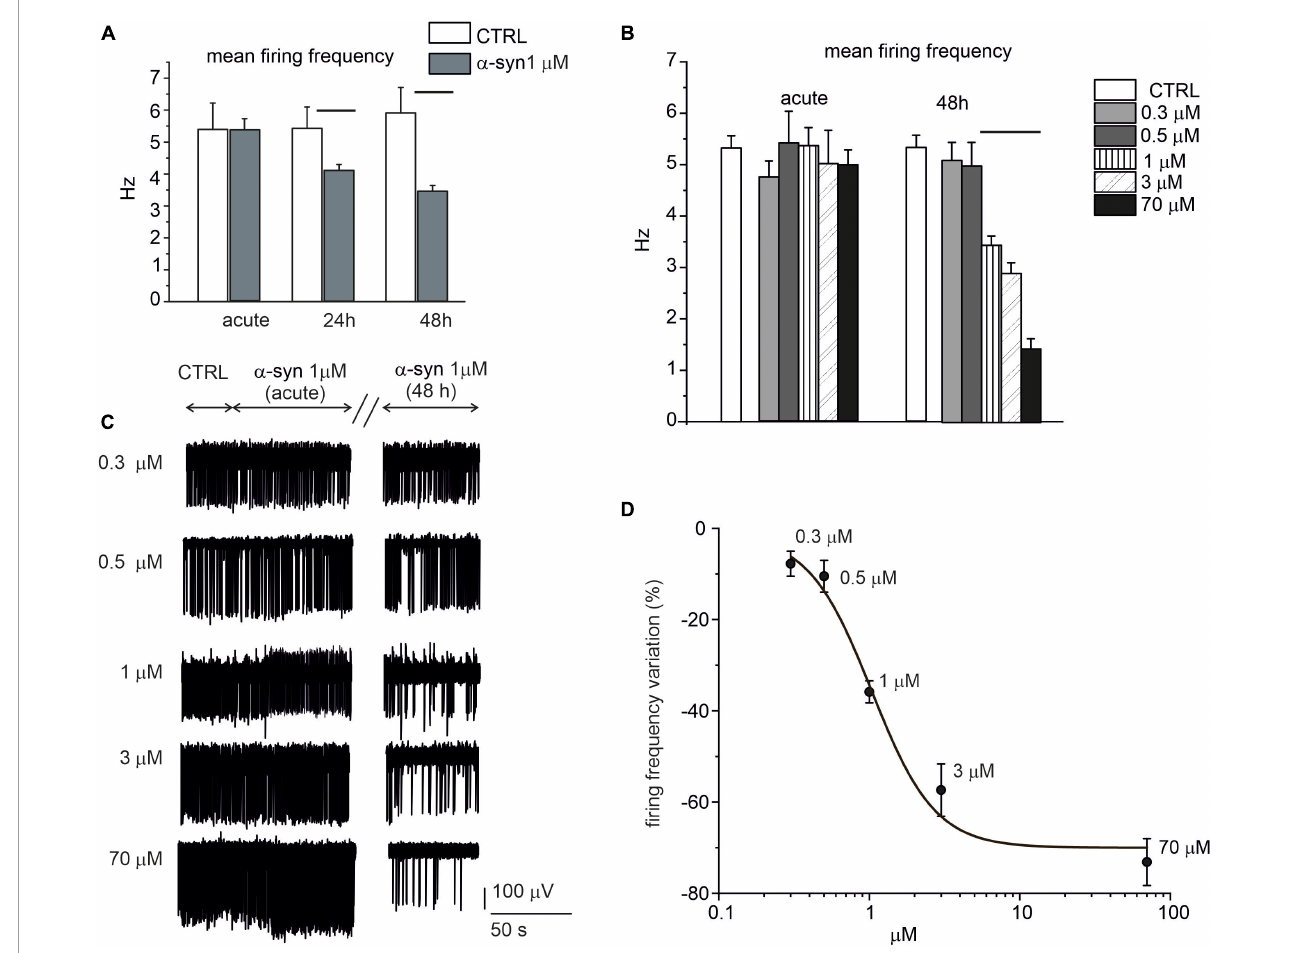
FIGURE8 Time and dose-response effect of exogenous α -syn on the firing frequency of 14 DIV neurons. (A) Mean firing rate is shown in the bar histograms, respectively, without α -syn (control, CTRL), after acute application, after 24 h exposure ( p = 0.004) and after 48 h exposure to α -syn 1 µ M ( p < 0.0001). (B) Mean values of the spontaneous firing frequency without α -syn (control, CTRL) and with increasing α -syn concentrations (ctrl vs. 1,3,70 µ M p < 0.0001), either after acute application and after 48 h exposure. (C) Representative traces, detected by the same microelectrode arrays (MEA) electrode without α -syn (CTRL) and with increasing concentrations of α -syn. The effect of α -syn has been monitored immediately after α -syn application (acute), after 24 and 48 h, respectively. For each condition, recordings lasted 120 s; only a part of the recordings has been shown in panel C for better visualizing the events. (D) Dose response inhibition of the firing rate (Hill fit curve gave IC 50 = 1.03 ± 0.25 µ M).